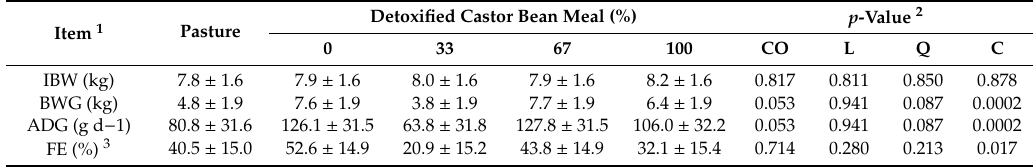
Table 6. Performance of lambs (mean ± SD) supplemented with or without castor bean meal via a creep-feeding